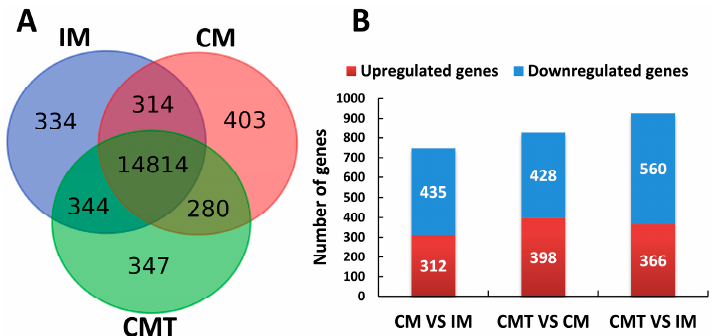
Figure 2. Gene expression analysis in VAT of IM, CM, and CMT pigs: ( A ) the numbers of genes expressed in IM, CM, and CMT groups; and ( B ) the numbers of DEGs between groups. IM: intact male pigs fed a HFC diet; CM: castrated male pigs fed a HFC diet; CMT: castrated pigs with testosterone replacement fed a HFC diet.